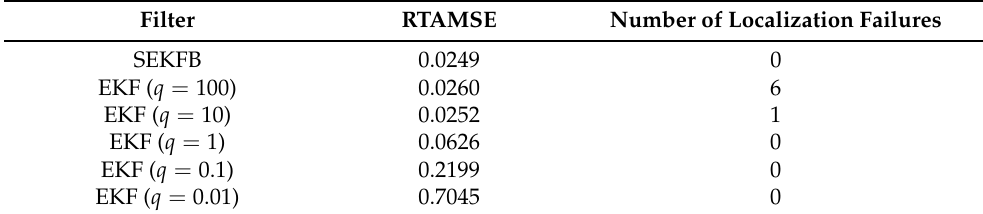
Table 2. Root time-averaged mean square error and number of localization failures.